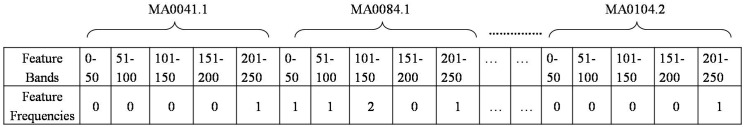
Feature vector of promoter 2.